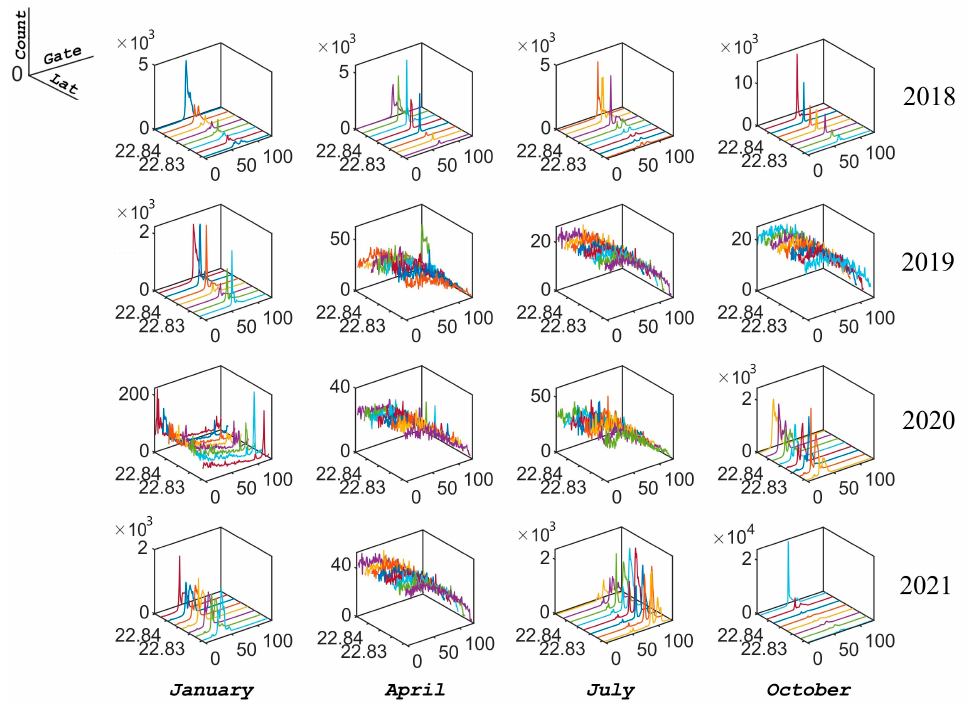
Figure 10. Echogram of NO. 175.1 virtual station arranged over time. The number on the right represents the year, and the word below represents the month.